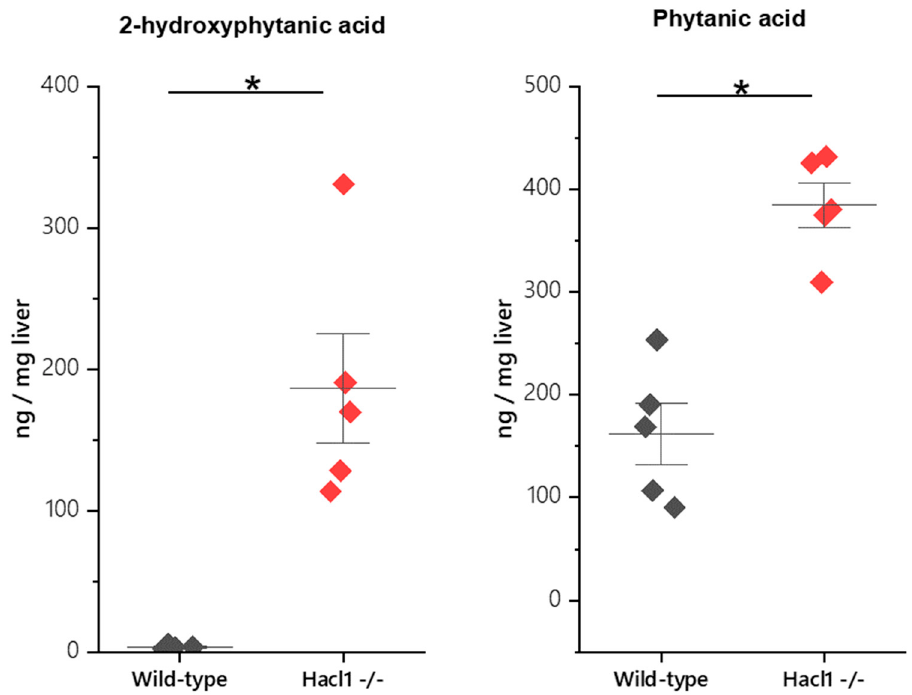
Figure 2. Phytanic acid and 2-hydroxyphytanic acid concentrations in mouse liver. Both fatty acids are significantly elevated in Hacl1 − / − liver (* indicates p < 0.01).